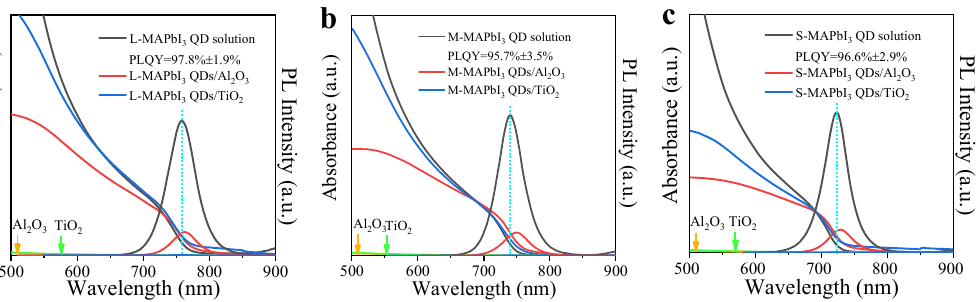
Figure 4. ( a ) PYS spectra of various size of MAPbI 3 QDs. The valence band energy level of measured QD sample was obtained from the extrapolation of the linear portion in the spectrum. ( b ) Tauc plot of the optical band gap energy for mesoporous TiO 2 fi lm calculated by extrapolation of the linear part of ( α hv ) 2 versus ( hv ). ( c ) PYS spectrum of mesoporous TiO 2 fi lm. ( d ) Schematic energy level diagram of the e ff ective transfer pathway of photogenerated carrier in MAPbI 3 QDs adsorbed on TiO 2 and Al 2 O 3 fi lms, CBM is conduction band minimum, VBM represents valence band maximum. ( e ) Diagram of relative energy levels of MAPbI 3 QDs of three kinds of size, TiO 2 and Al 2 O 3 .